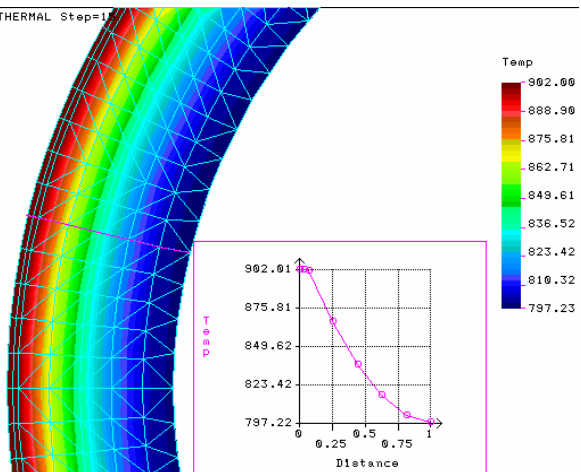
Fig 9 . Temperature distribution in the cross-section of the HC-FST column after 45 min from the standard fire